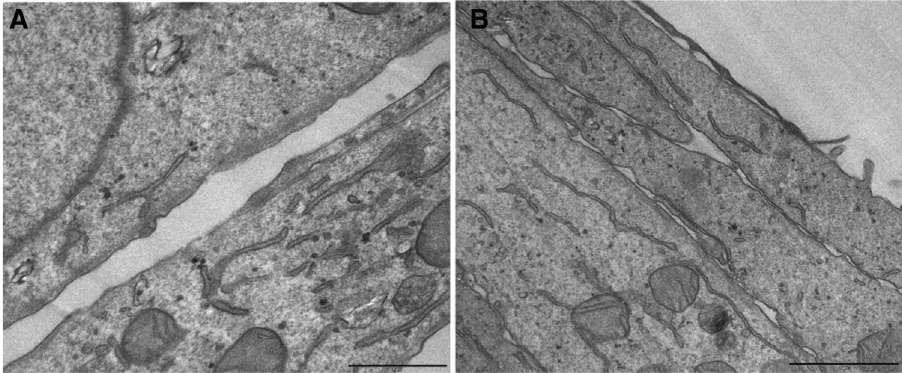
Figure 3. TEM of ultrathin sections of Vero cells ( A ) and Vero cells treated with 0.5 μg/mL TIZ for 24 h ( B ).